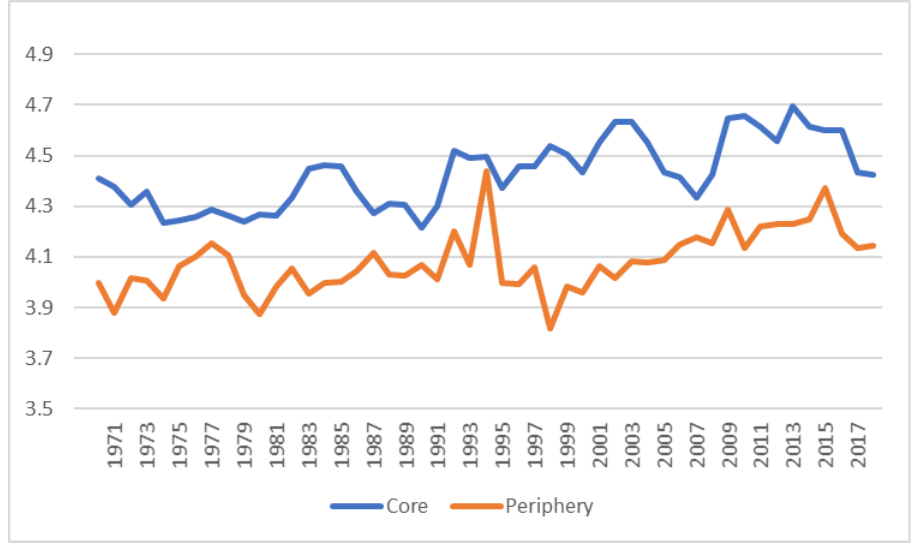
Figure 5: Average Educational Expenditures as a Percent of GDP in Core and the